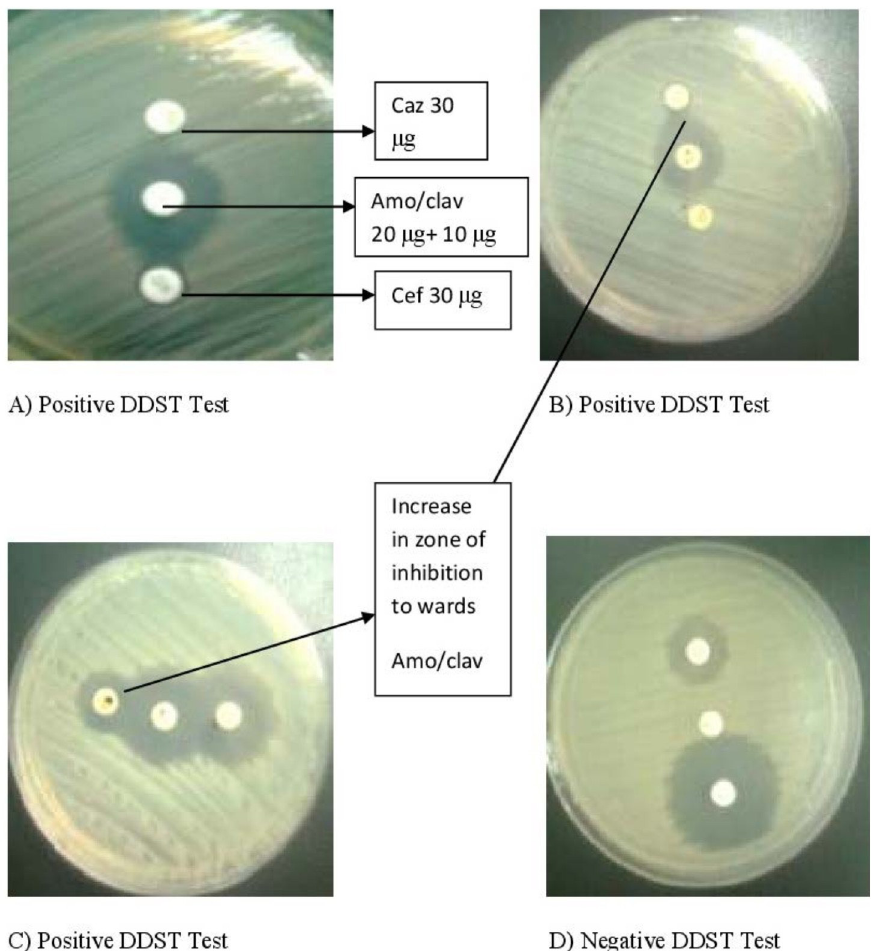
Fig. 4. Extended-spectrum ß-Lactamase (ESBL) Positive Isolates by Double Disc Synergy Test